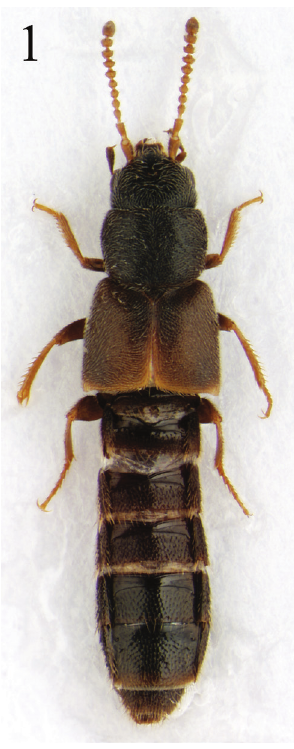
Figure 1. Habitus of Iotarphia rufobrunnea sp. n., 3.4 mm. yellow, elytra reddish brown except for basal darker region; surface slightly glossy, densely pubescent with fine microsculpture. Head . Slightly transverse, approximately 1.1–1.2 times as wide as long, widest across eyes, narrower than pronotum; eyes slight- ly large and prominent, about 1.2 times as long as temples; gular sutures moderately separated, slightly diverged basally. Antennae (Fig. 7) slightly moniliform and about as long as head and pronotum combined; antennomeres 1–3 elongate, 1 longest, 2 distinctly longer than 3, 4–10 slightly to distinctly transverse, 11 longer than wide, slightly shorter preceding two combined. Mouthparts . Labrum (Fig. 2) with 8 macrose- tae on each side of midline; epipharynx with several sensilla, including 2 lateral sensory rows on each side of midline; α -sensillum setaceous, about as long as ε -sensillum; β - and γ -sensilla short. Mandibles (Fig. 3) slightly asymmetrical, subtriangular, decurved and narrow apically, about 1.6 times as long as basal width, with blunt internal tooth; prostheca developed, composed of three portions, many small denticles present in mo- lar region. Galea and lacinia of maxilla (Fig. 4) moderately long and slender; lacinia composited of seven small spines in distal comb region, two isolated spines longer; maxillary palpus distinctly 4-articled, elongate and pubescent; palpomere 1 smallest, 2 about 2.5 times as long as wide, 3 slightly longer than 2, about 3.0–3.2 times as long as wide, 4 digitiform and relatively short, filamentous sensilla reaching to basal